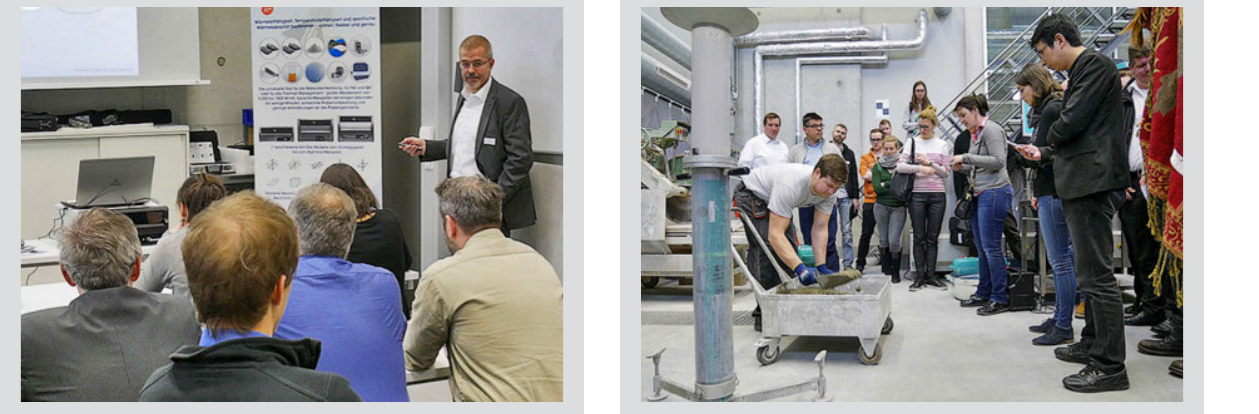
Figure 4: Workshop for rheological measurements with Sliper and eBT-V at the concrete laboratory of the OTH Regensburg.